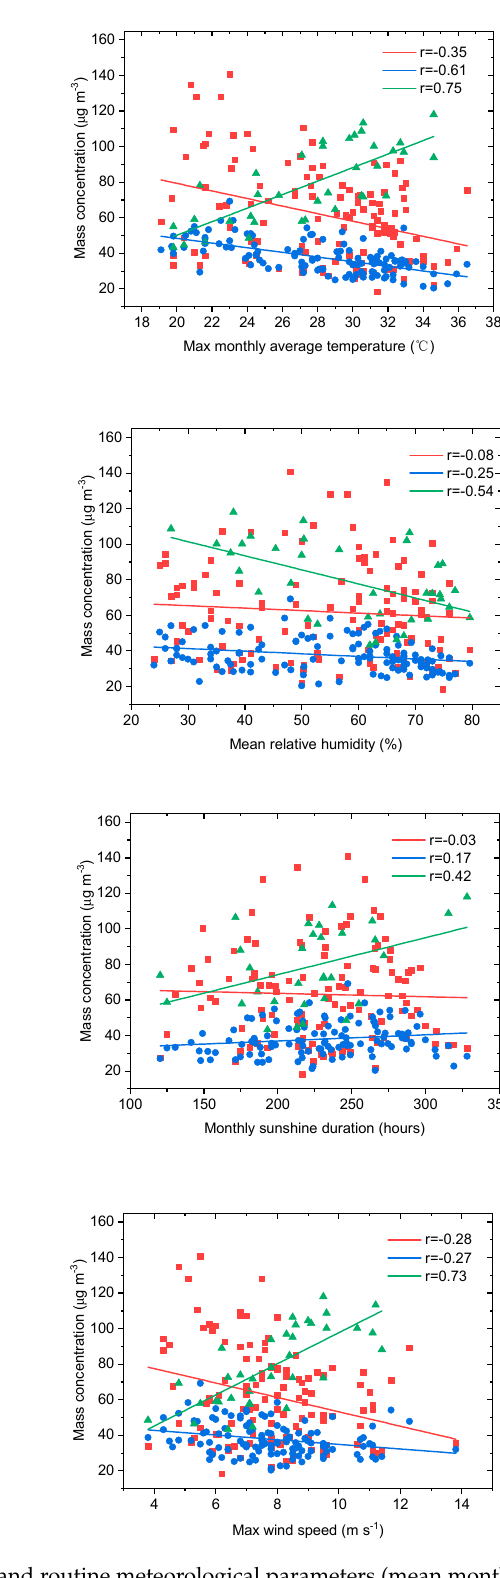
Figure 8. Relationships between SO 2 , NO 2 , O 3 , and routine meteorological parameters (mean monthly average temperature, maximum and minimum monthly average temperature, mean relative humidity, monthly total precipitation, monthly sunshine duration, mean wind speed, and maximum wind speed) in Panzhihua of the economic zone of Western Sichuan Plateau.